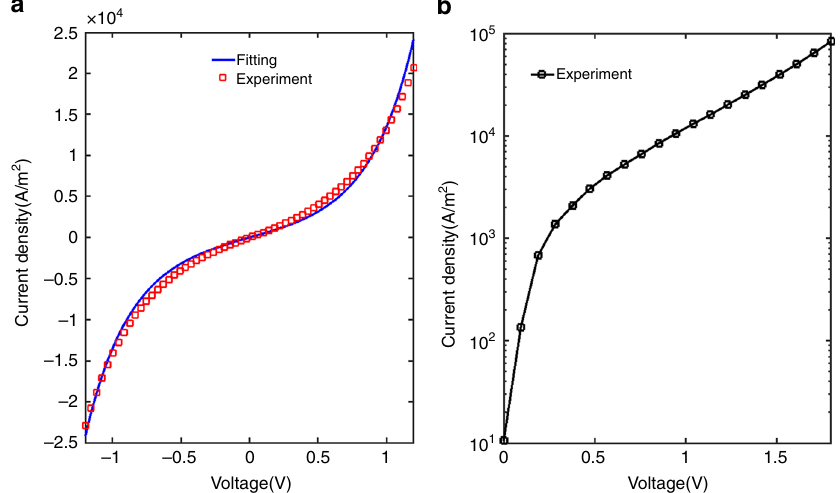
Fig. 2 J ( V ) characteristic of ASPEIT junction. a Red dots: J ( V ) experimental data, blue line: fi tted curve based on the Simmons model ( fi tting parameters: barrier thickness of 3 nm and mean barrier height of 2.01 ± 0.03 eV, effective electron mass 0.23 m e ). b Semi-log plot of J ( V ) showing the exponential behavior